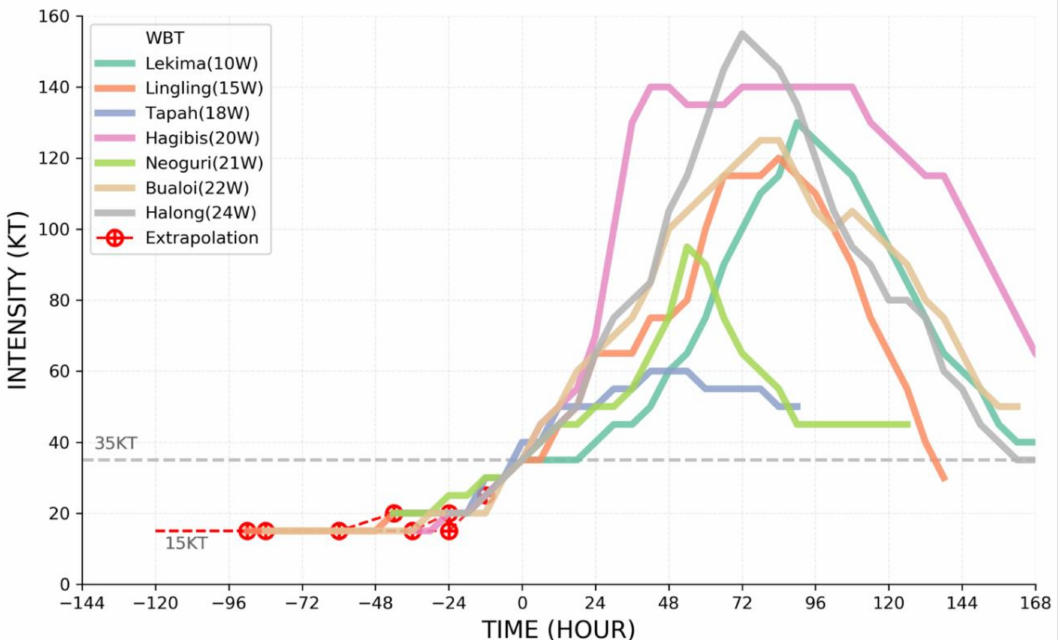
Figure 2. JTWC Working Best-Track (WBT) intensities (kt) plotted relative to the T2F (35 kt) labeled as Time = 0 for seven western North Pacific tropical storms (names and JTWC numbering in inset) during the 2019 typhoon season. For pre-T2F (35) times when the ECEPS had predicted a pre-TC circulation starting prior to the beginning of the JTWC WBT, a backward intensity extension (blue dashed line with circled blue crosses) of the WBT intensities was used to specify an intensity for validation of the ECEPS intensity predictions (see Appendix